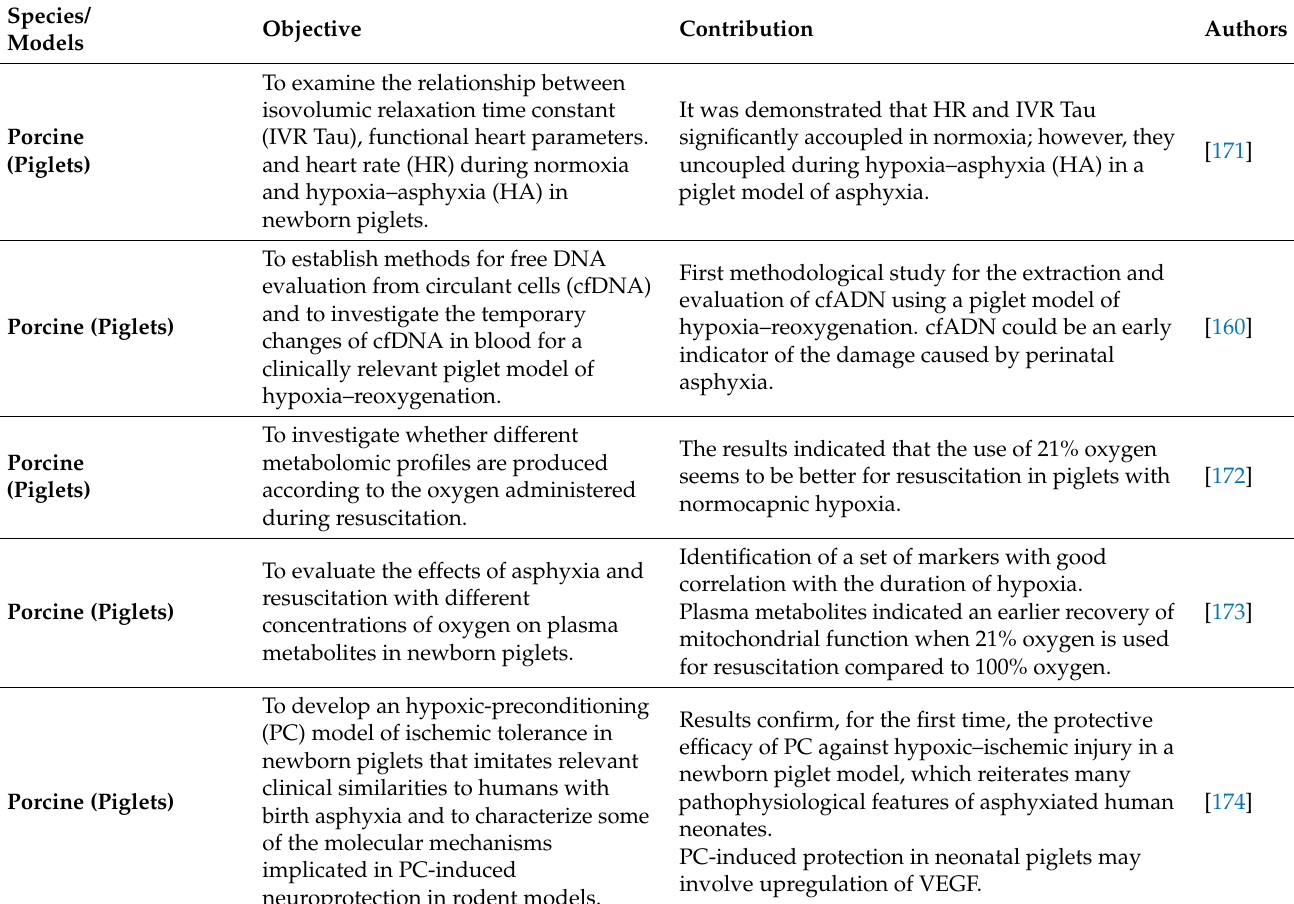
Table 2. Relevant findings of studies related to perinatal asphyxia in